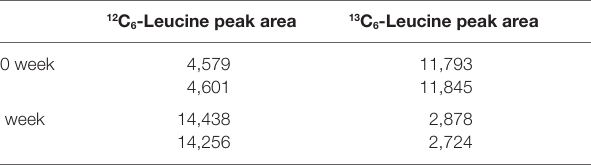
TaBle 2 | Plasma leucine in labeled APP/PS1